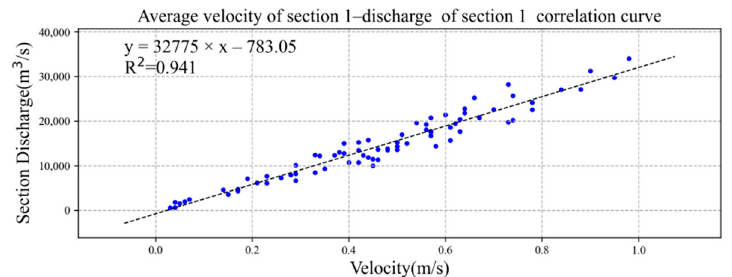
Figure 9. Linear correlation between average velocity of section 1 and total discharge of section. The data of blue dots represent the relationship between average velocity of section 1(x) and total discharge of section 1(y).